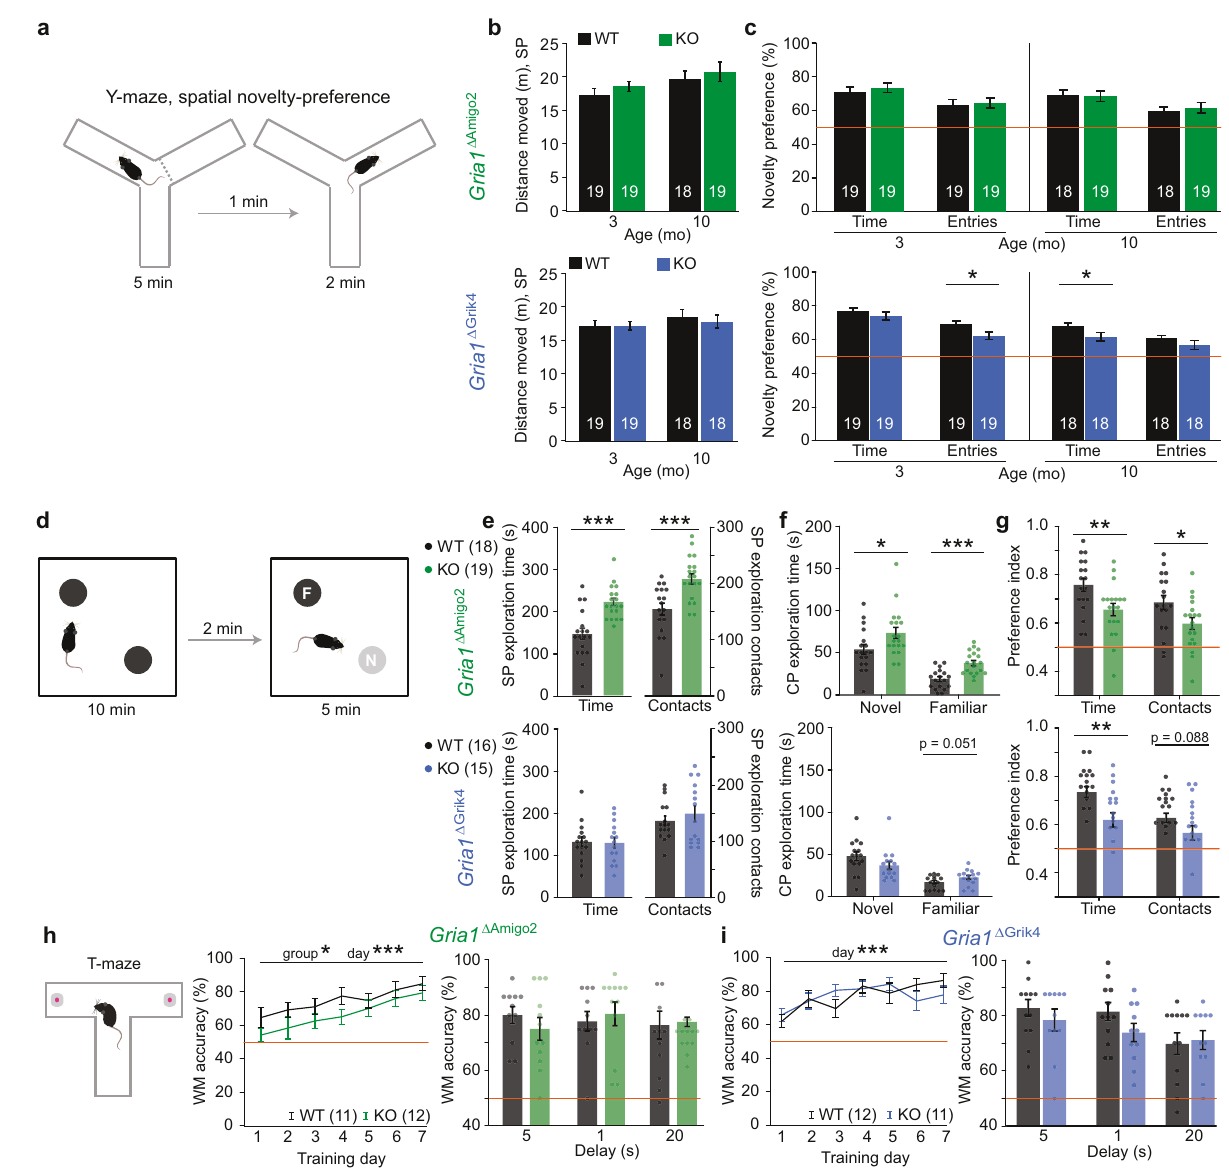
Fig. 3 Ablation of GluA1 from CA2/CA3 impairs short-term memory. a Illustration of Y-maze SNP task of spatial short-term habituation. b Locomotor activity in the sample phase (SP) for the cohorts stated on the left tested at different ages ( x axes). c Preference for the novel arm in the test phase of the Y-maze, conducted at the indicated ages, calculated from residence time or the number of entries, as stated. d Illustration of the novel object-recognition test (NOR) of object-related short-term habituation. e Exploration of the two identical objects in the sample phase measured as interaction time (left) and the number of contacts (right). f Interaction time with novel and familiar object in the NOR choice phase (CP). g Preference for the novel object calculated as interaction with novel object relative to interaction with both objects combined using interaction time or the number of contacts as the indicator. h – i WM performance during the 7 initial training days in the T-maze rewarded alternation task ( h ) and in protocols with distinct delays ( i ); the data shown for the 5 s delay are the average of the last 3 training days shown in ( h ); the 1 s delay was tested with an ITI of 20 – 25 s, while the ITI was 5 – 7 min for the other protocols. In ( b , c , e – i ), the cohort is identi fi ed above or to the left of the panels and colour-coded, with KO mice and control groups of each cohort in colour and black, respectively. N − numbers are stated in colour legends or bars of each panel; the two cohorts were treated separately for statistics. RM-ANOVA was used for analysing data over time ( h , i ), univariate ANOVAs for the remainder using genotype and sex as independent variables; the T-maze was only conducted in males. See Supplementary Tables 3 and 4 for exact statistical results. Dot graphs represent individual mice, all other show mean ± s.e.m. Orange line indicates chance level, where applicable. *** P < 0.001, ** P < 0.01, * P <